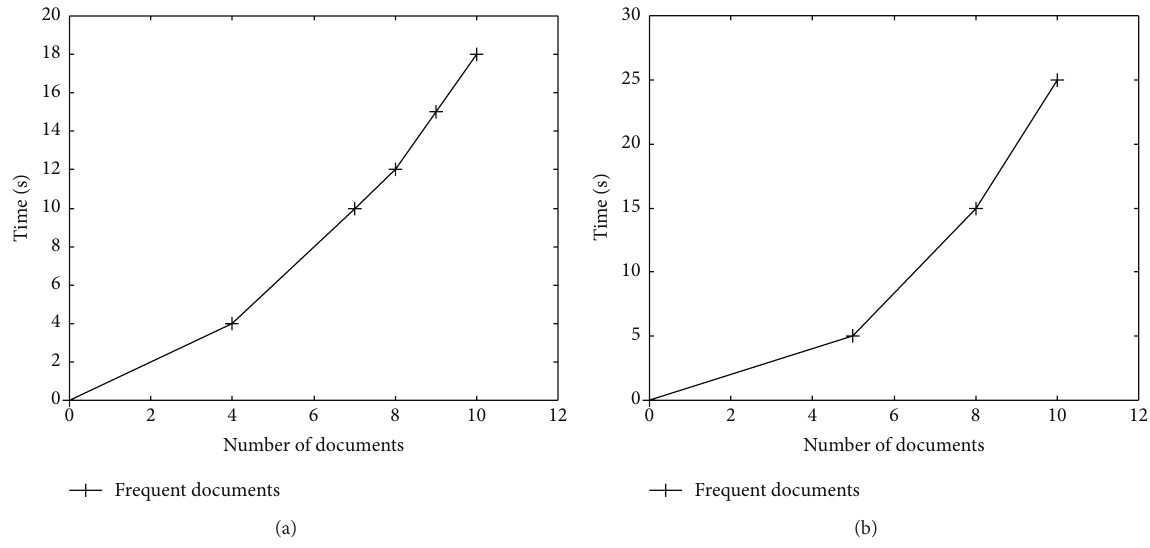
Figure 1: Frequent documents summarization: (a) Na¨ıve Bayesian classifier (proposed) and (b) MEAD (existing).